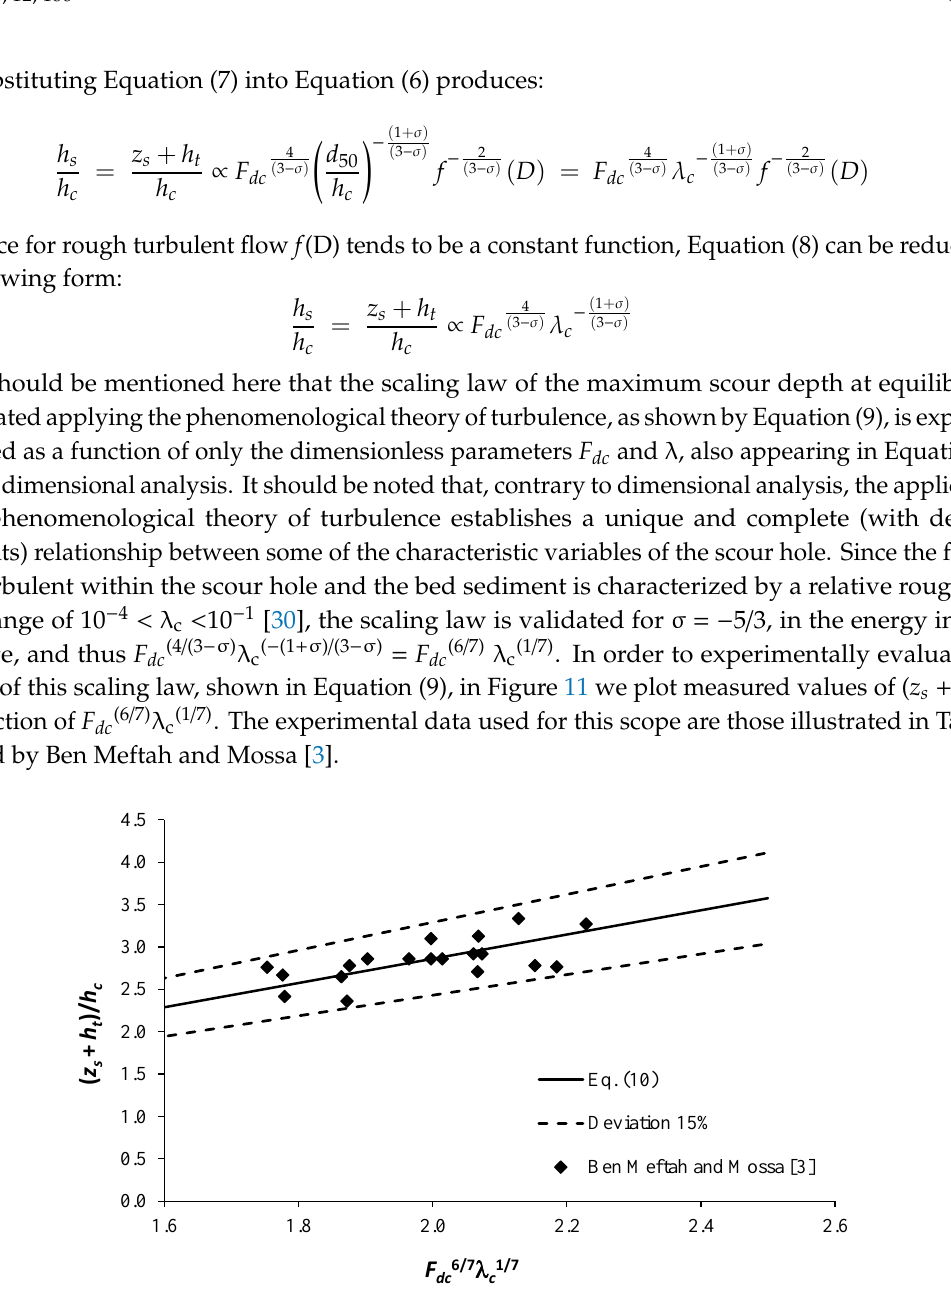
Figure 12. Validation of the scaling law of the maximum scour depth using data obtained by Bormann and Julien [4] downstream of grade control structures of different features and with sediment sizes of d 50 ranging between 0.30 and 0.45 mm, Re g ranging between 396 and 2093 and with relative roughness in the range of 10 − 4 < λ c <10 − 2 . The scaling law is validated for σ = − 5/3, in the energy inertial subrange. 4. Conclusions Considering that an exhaustive prediction of the scour development is fundamental for structural stability, we examined experimentally the local scouring processes downstream of hydraulic grade control structures. This study focuses on the analysis of flow hydrodynamic structures within the scour hole at equilibrium and on the application of the phenomenological theory of turbulence to find a scaling law predicting the equilibrium scour depth. Specifically, by means of velocity measurements, we observed that at equilibrium conditions the flow in the scour hole is fundamentally characterized by three distinct regions: (i) A first region consists of a free entering jet flow, plunging from the crest of bed sill into the scour hole and strongly eroding the bed sediments; (ii) a second region located near the scour bottom, extending upstream